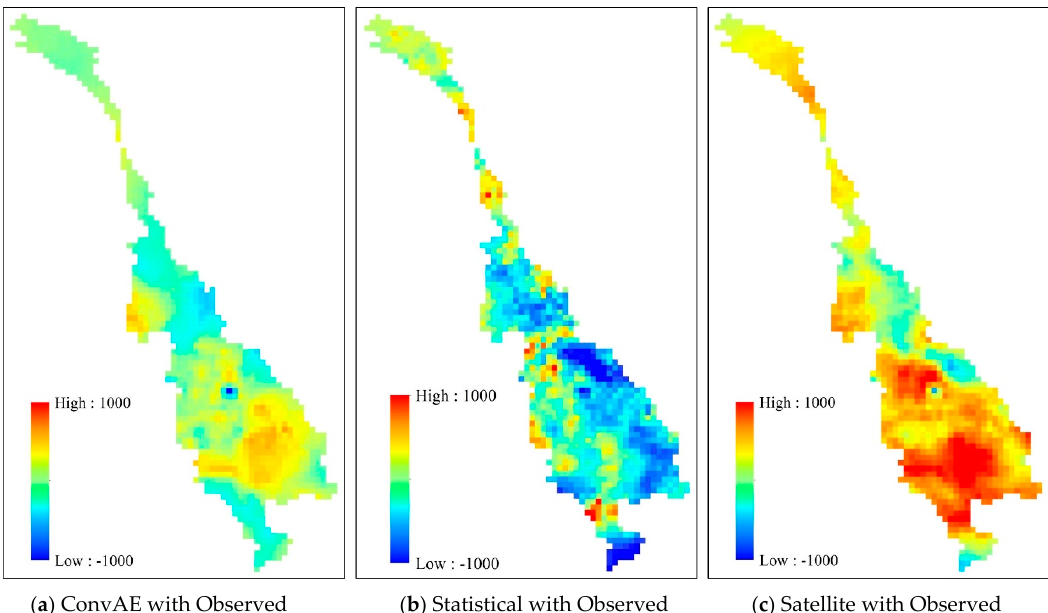
Figure 16. Spatial bias distribution pattern of the precipitation products compared to the observed data in 2015.